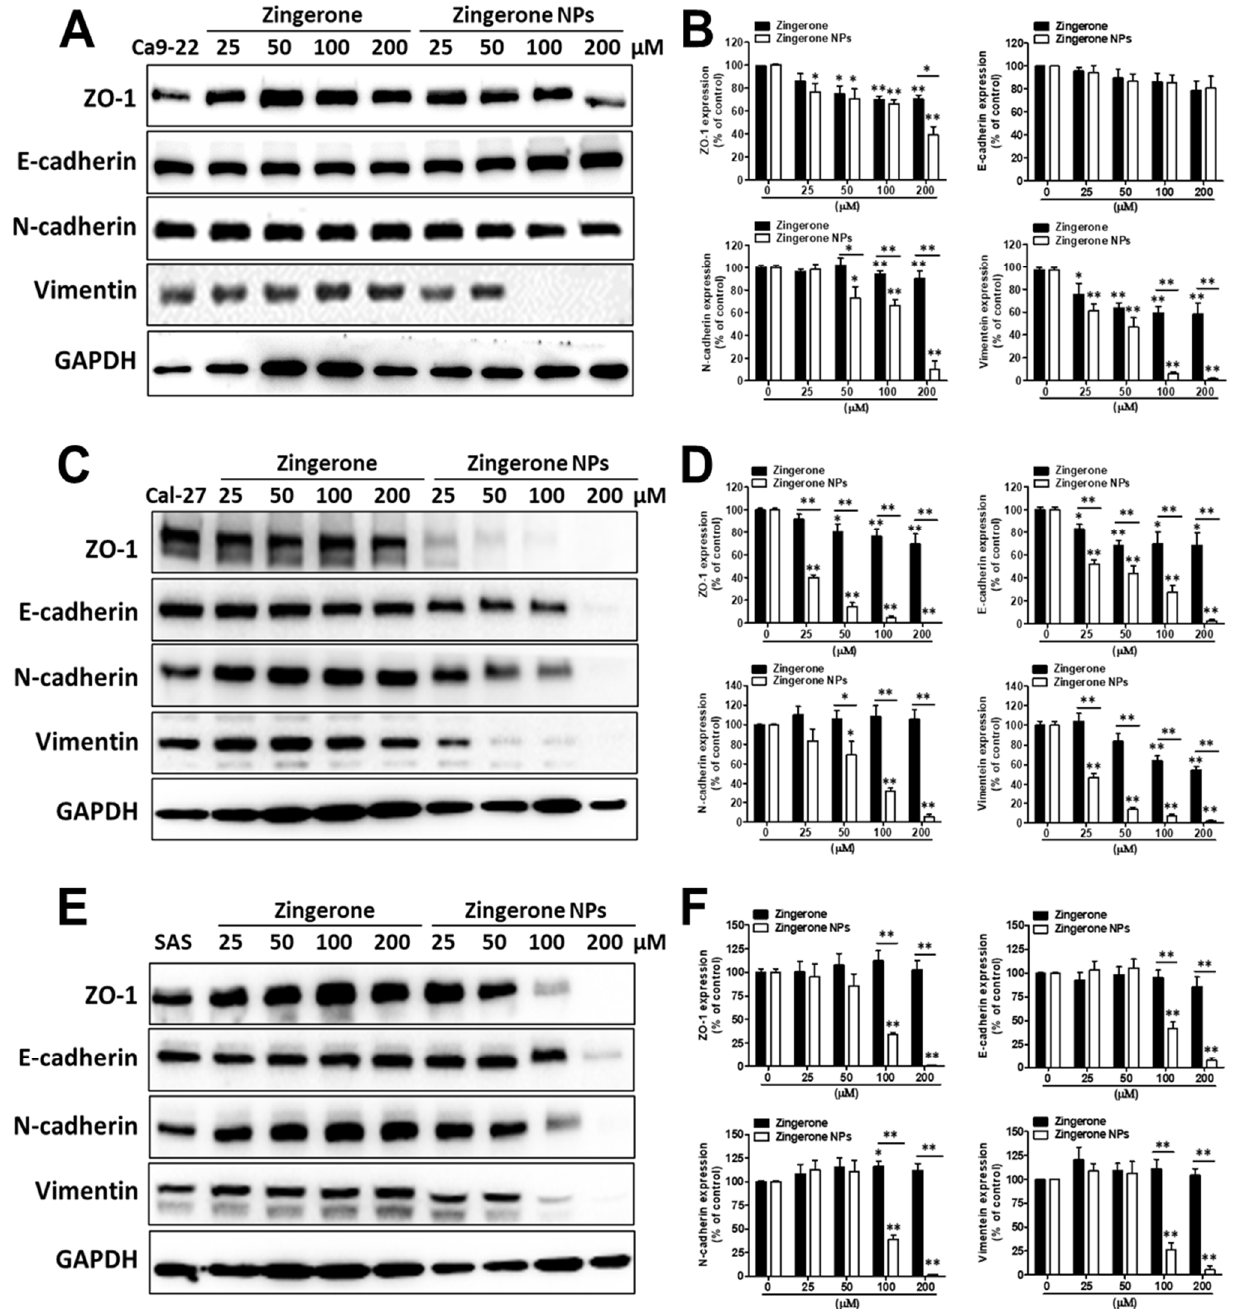
Figure 7. Zingerone NPs disturbed the expression levels of EMT-associated proteins in human OSCC cell lines. Cells were treated with zingerone and/or zingerone NPs for 24 h. The EMT-associated proteins, including ZO-1, E-cadherin, N-cadherin, and vimentin, were analyzed and quantitated on Ca9-22 cells ( A , D ), Ca1-27 cells ( B , E ), and SAS cells ( C , F ), respectively, using Western blotting assay. Data are expressed as mean ± SEM of three experiments. * p < 0.05, ** p < 0.01.